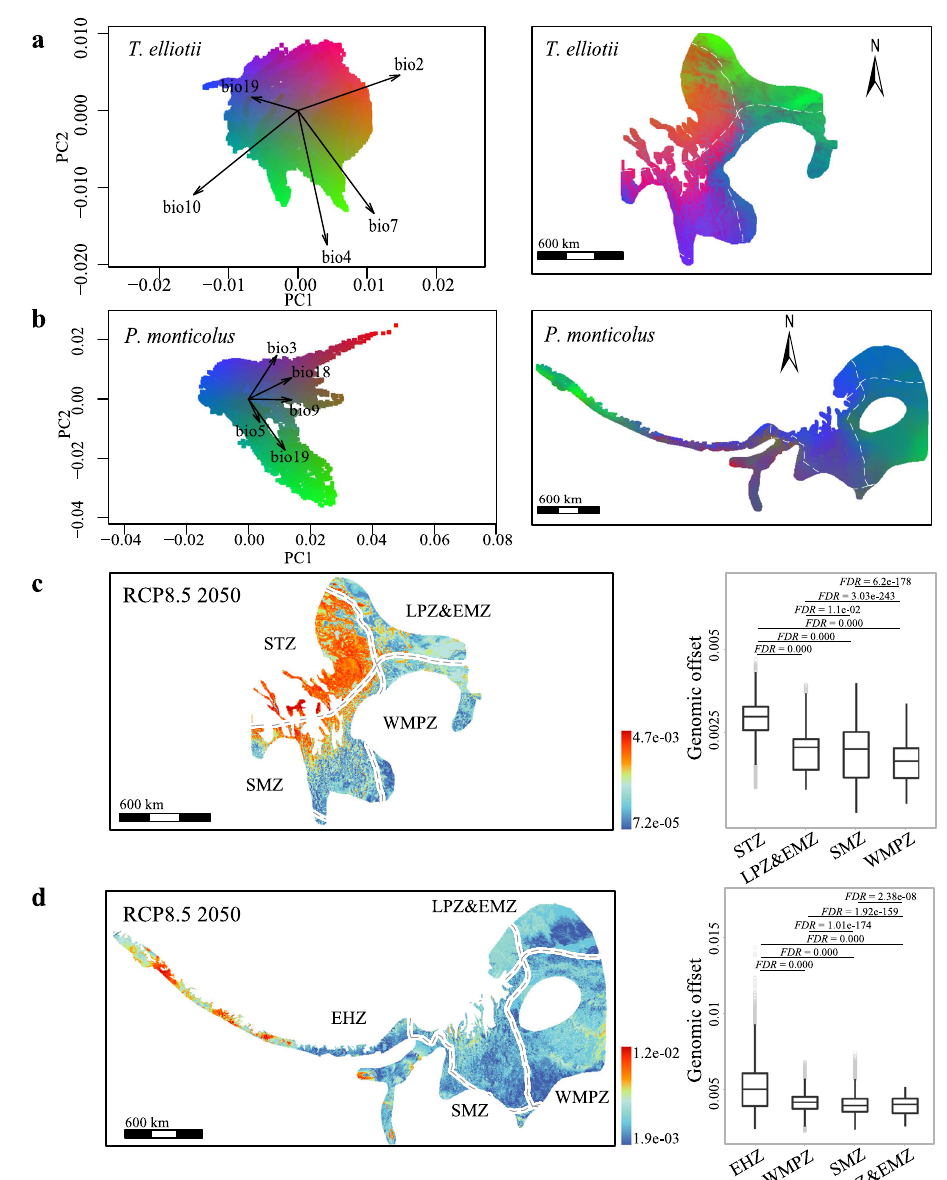
Fig. 3 | GradientForest modelling genotype-climate associations and genomic offsets to future climate conditions of the two mountainous species. a , b Left, principal component analyses of gradientForest transformed climatic variablesfor T. elliotii ( a ) and P. monticolus ( b ). Arrows show the loadings of the top-ranked uncorrelated climatic variables. The labelled vectors of the fi rst two principal components indicate the direction and magnitude of correlation. Right, gra- dientForest transformed genotype-climate association across the distribution rangesof T. elliotii ( a ) and P.monticolus ( b ).The differencein geneticcomposition is mapped by assigning the three principal components to the RGB colour palette accordingtothegradientForestmanual,withtheresultingcolourcorrespondingto the expected patterns of genetic composition. c , d Left, the gradientForest pre- dicted genomic offsets under RCP8.5 2050 in T. elliotii ( c ) and P. monticolus ( d ). Right, populations in the western parts of the distributions, i.e., the southern Tibetan zone (STZ, T. elliotii , n =12,912 grids) and eastern Himalayan zone (EHZ, tion across these SNPs, we visualised the genotype-climate turnover surface across the distribution ranges of the two species using the fi rst three principal components (PCs) of the gradientForest out- puts. We found that the genotype-climate associations vary from